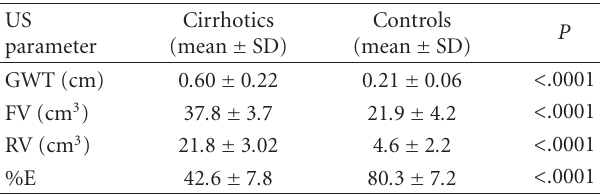
Table 3: Gallbladder US parameters in cirrhotic patients and healthy